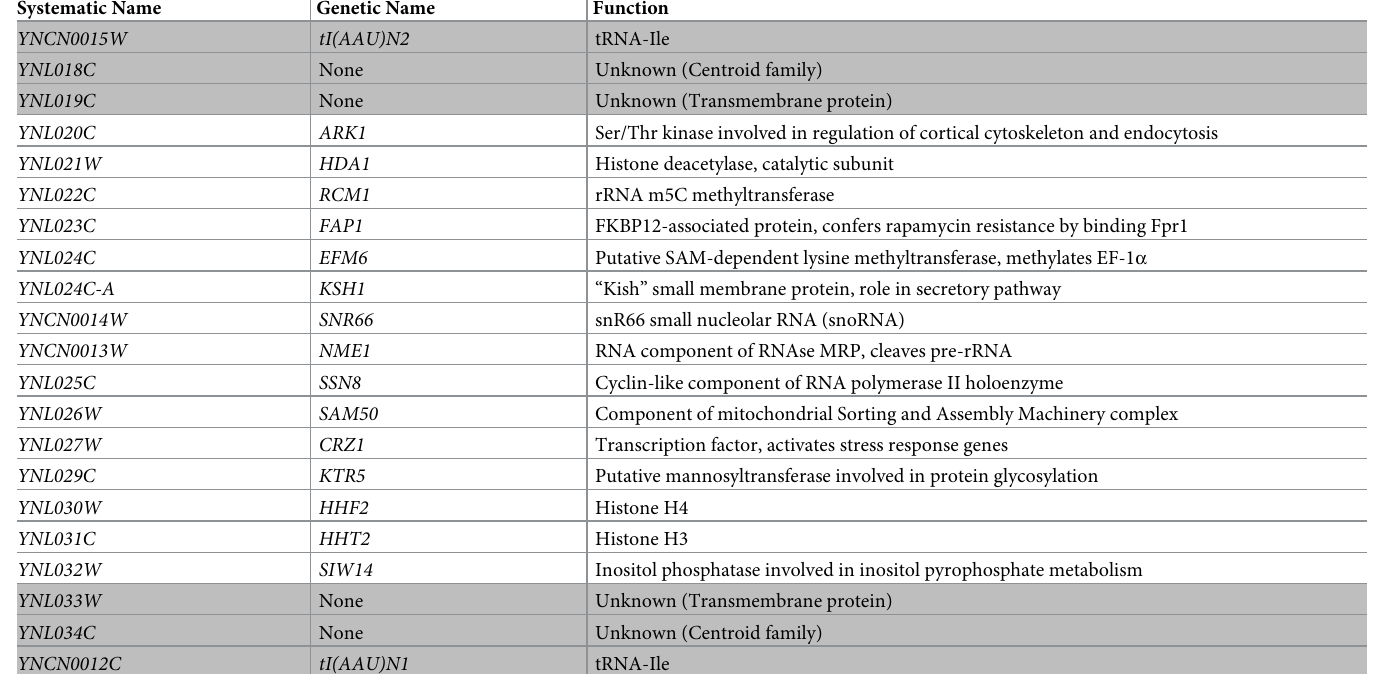
Table 1. Functions of genes located in the FF region and the IRs. Gray shading indicates genes located in the IRs; the other genes are in the FF region. Descriptions are based on Saccharomyces Genome Database annotations. Systematic